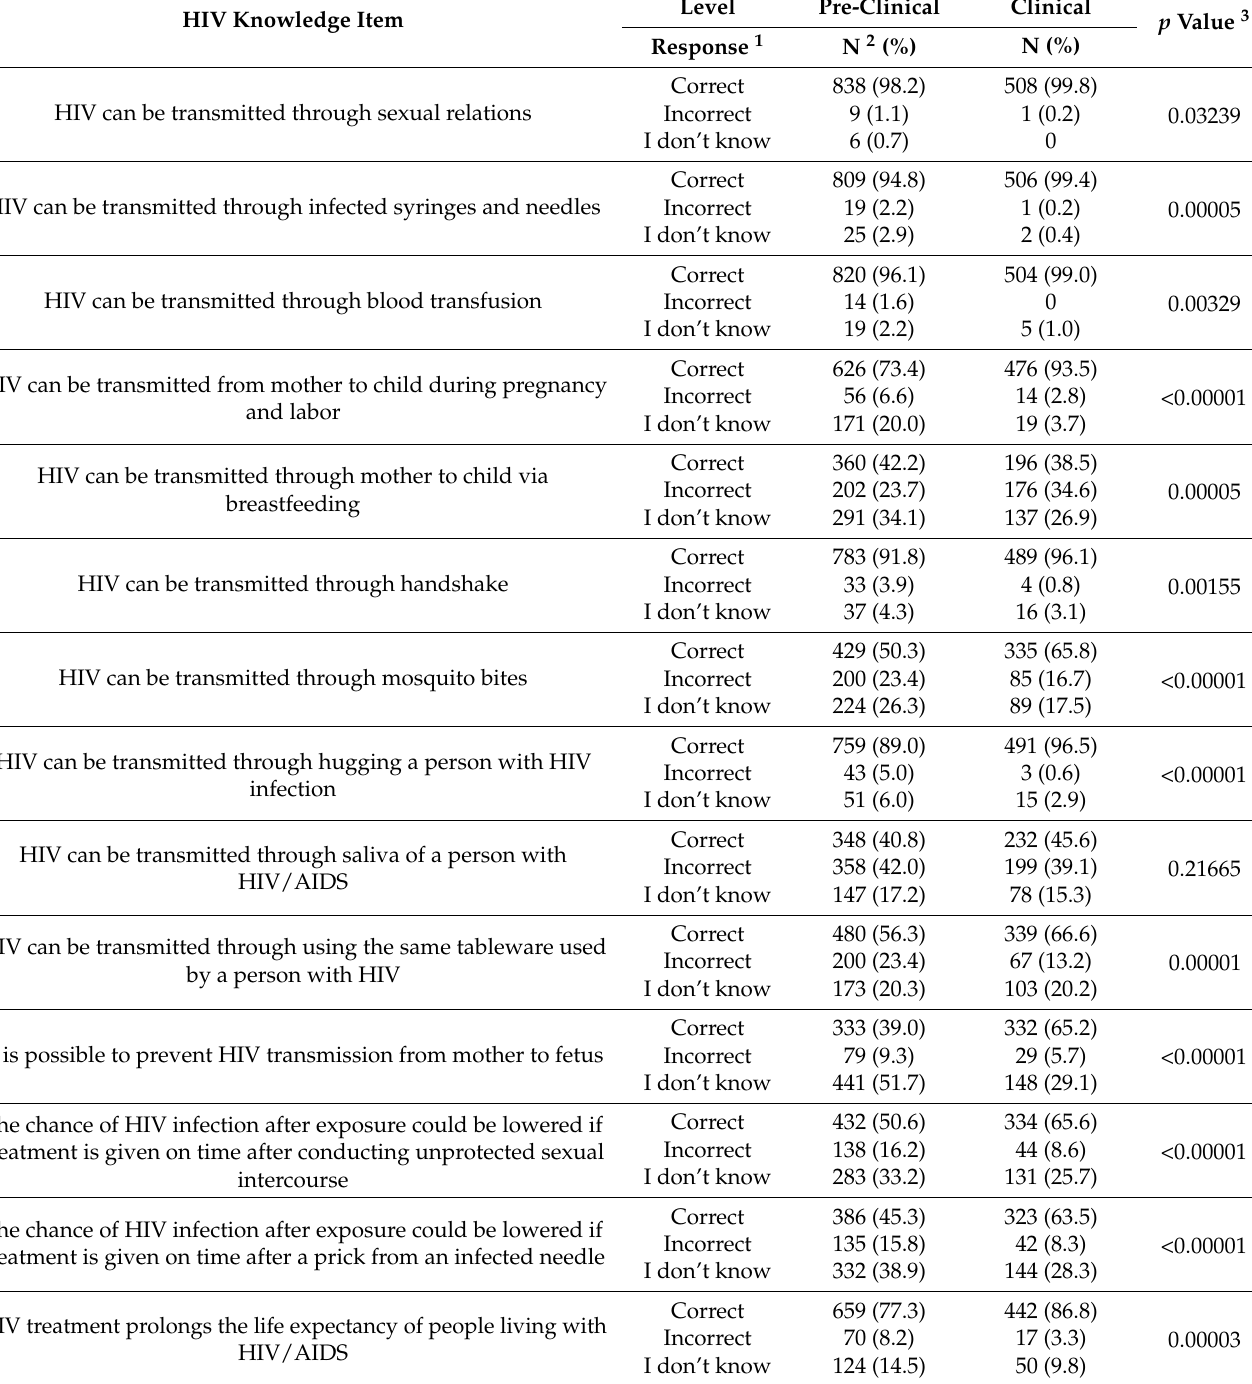
Table 2. Comparison of HIV knowledge among pre-clinical vs. clinical